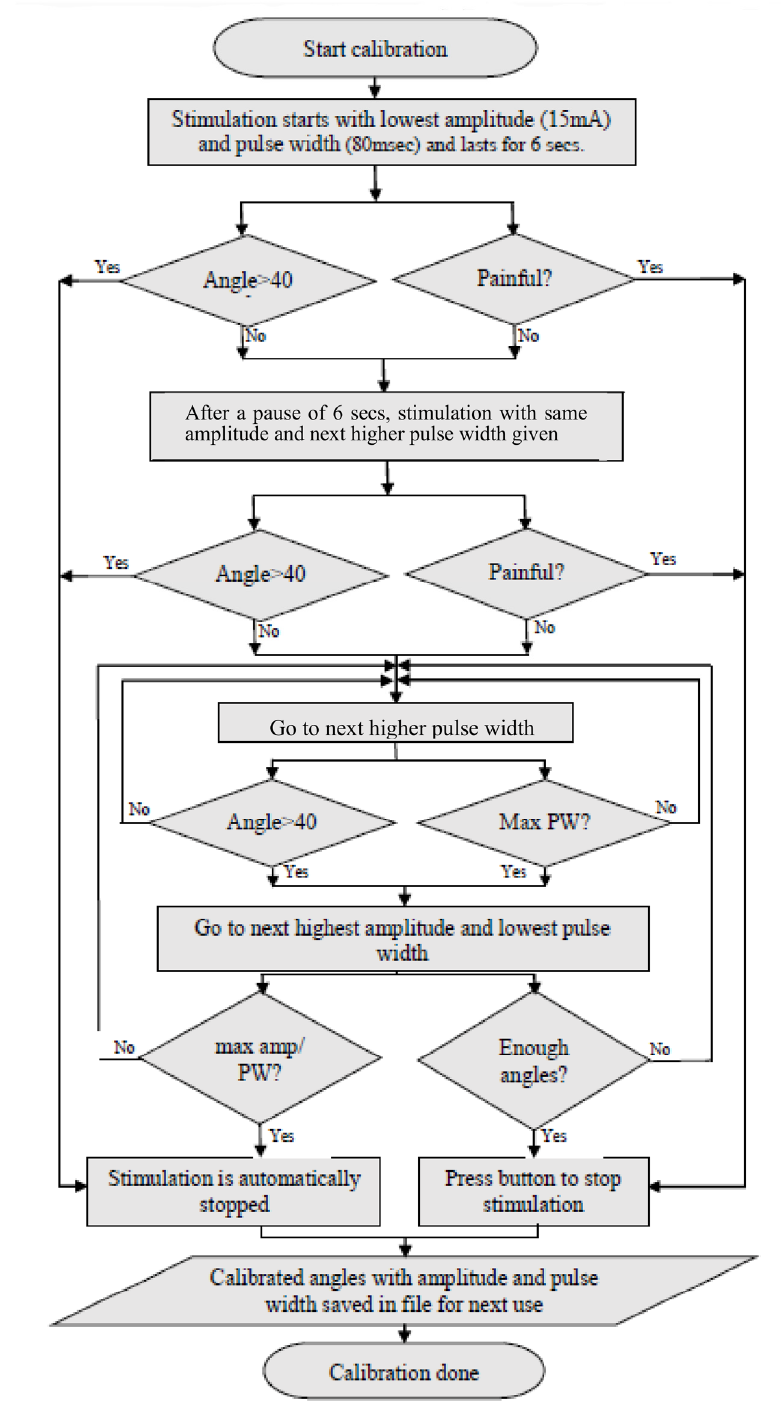
Figure 3. Algorithm followed by the calibration app. Calibration is performed to create the table for use during stimulation